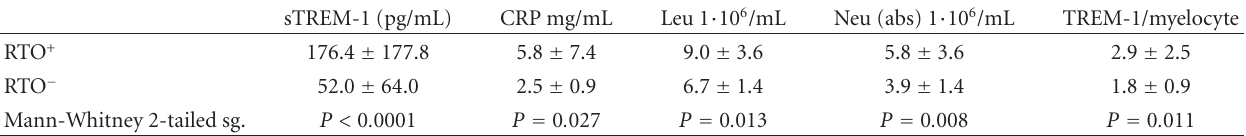
Table 4: Comparison of plasma levels of investigated parameters in asthma bronchiale patients with and without respiratory tract obstruction.